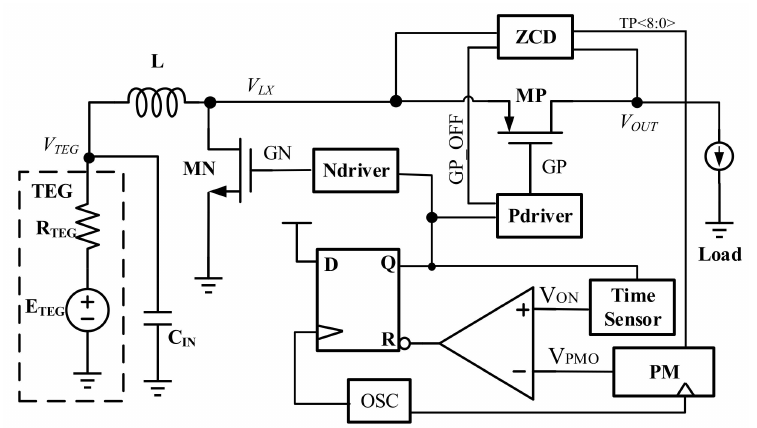
Figure 6. The architecture of the proposed MPPT